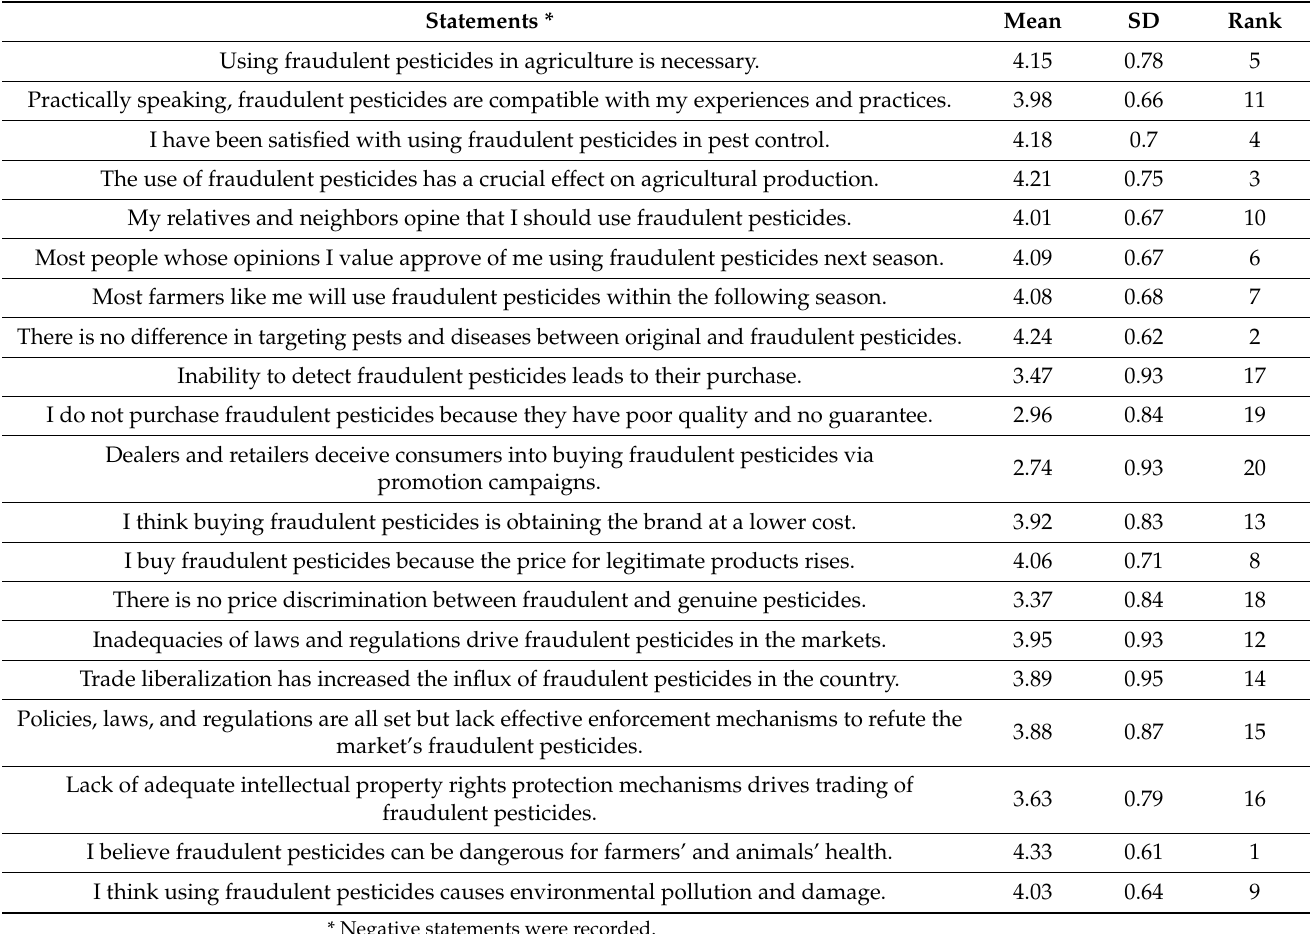
Table 2. Mean ranking of farmers’ perception of fraudulent pesticides’ drivers in the market. Statements * Mean SD